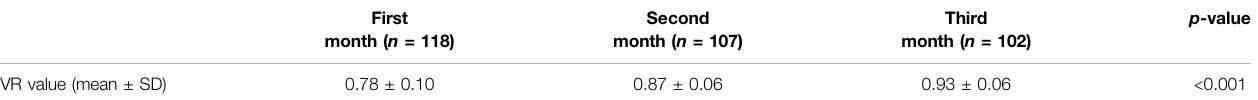
TABLE 1 | Early PVR value of the regenerated callus during distraction osteogenesis.